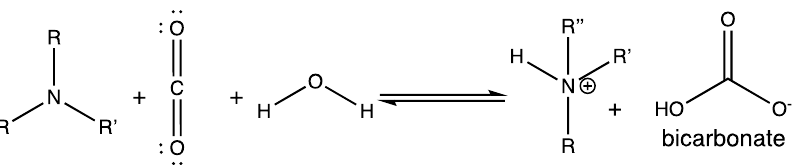
Figure 11. Tertiary amines react with carbon dioxide in the presence of water to give